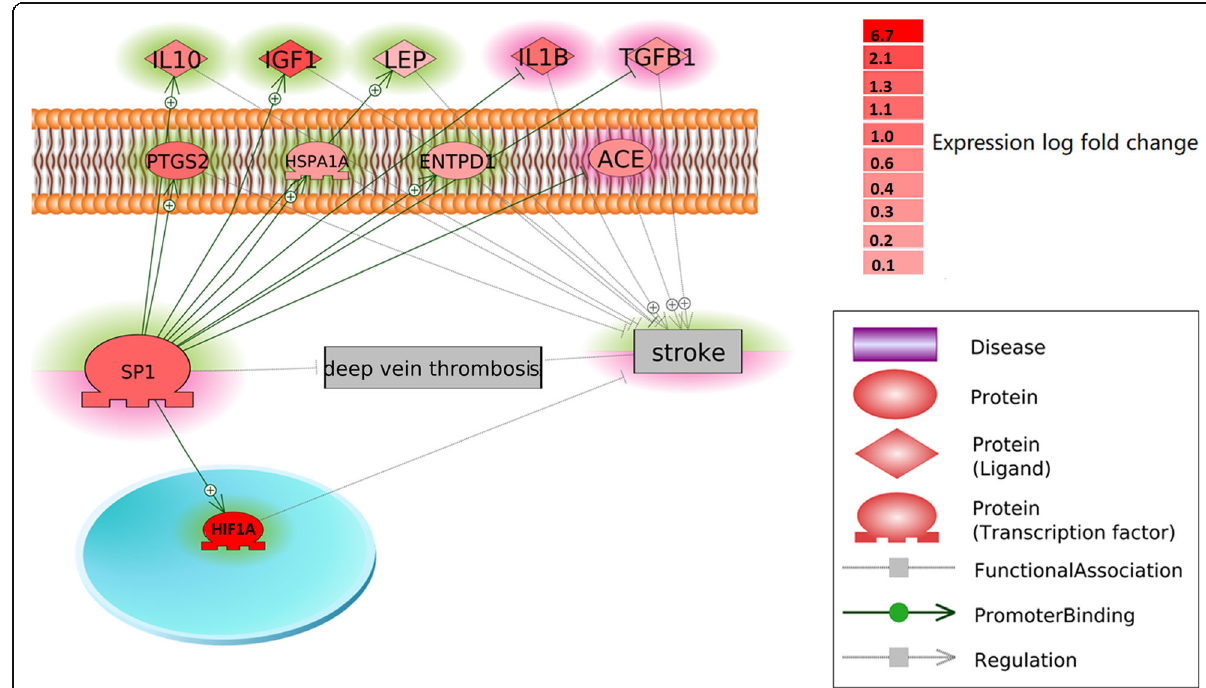
Fig. 2 Functional pathway between stroke and gene SP1 . The pathway was firstly built by using Pathway Studio, where the relations between any of the two entities were supported by one or more references. Then, a meta-analysis has been conducted for each of the genes presented in the pathway using the 12 datasets employed in this study. The genes are color-coded by their expression log fold change. The genes highlighted by green were supported by the meta-analysis results, while the red-highlighted ones were